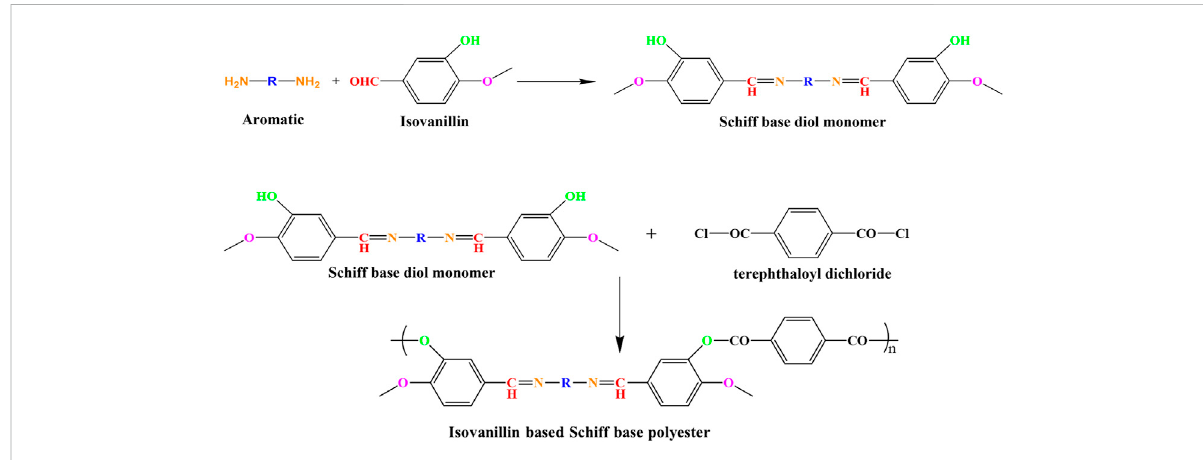
FIGURE 7 Synthesis route of Schiff base polyester (Ibrahim and Shabeer,